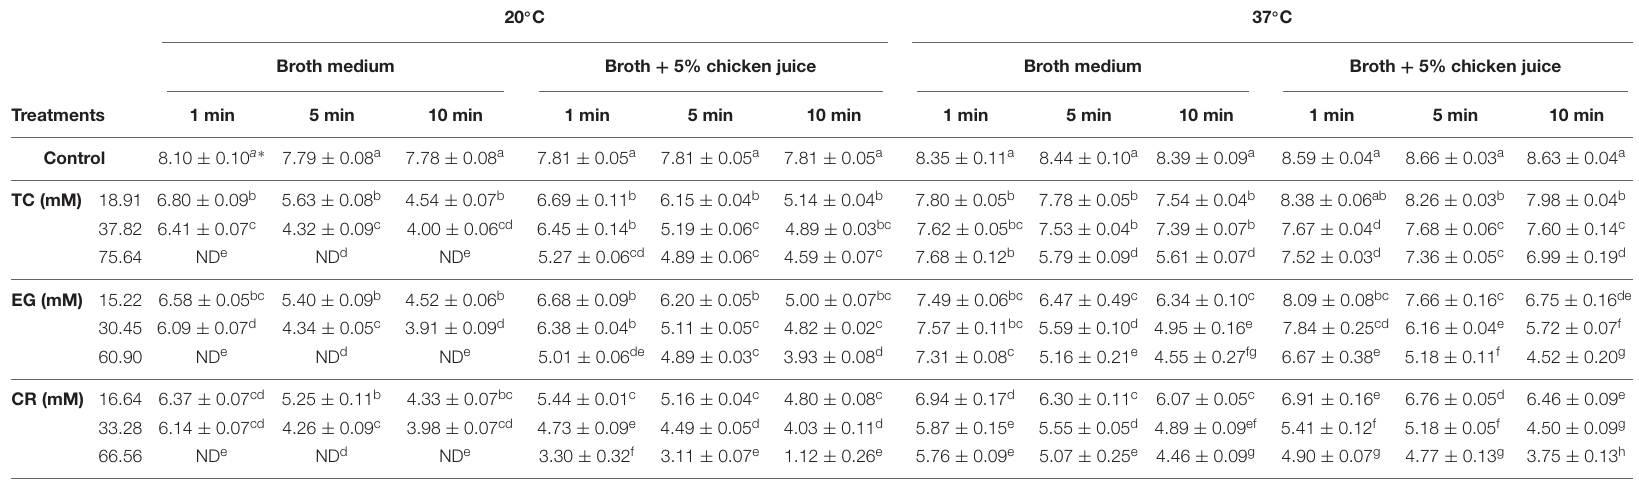
TABLE 2 | Effect of trans -cinnamaldehyde (TC; 18.91, 37.82, 75.64 mM), eugenol (EG; 15.22, 30.45, 60.90 mM), and carvacrol (CR; 16.64, 33.28, 66.56 mM) on mature Campylobacter jejuni NCTC 11168 biofilm formed on polystyrene microtiter plates at 20 ◦ C or 37 ◦ C in the broth medium and in the presence of chicken meat juice ( n = 6).